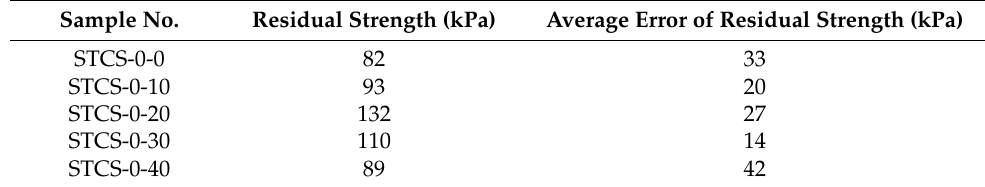
Table 7. Residual strength of each group of